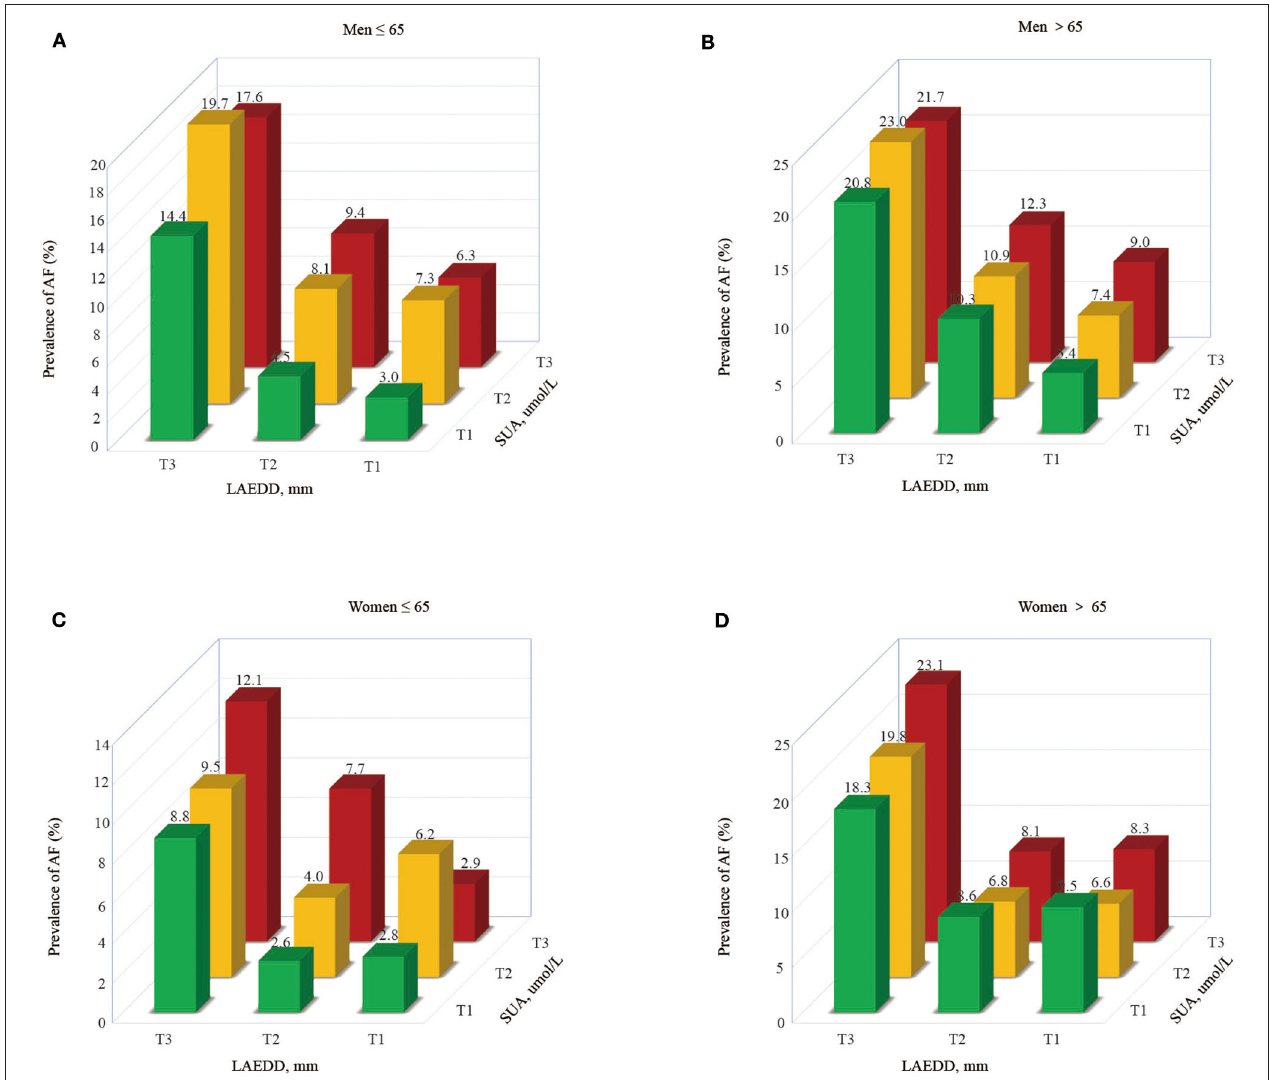
FIGURE 2 | The prevalence of AF based on LAD tertiles in patients grouped by SUA tertiles.